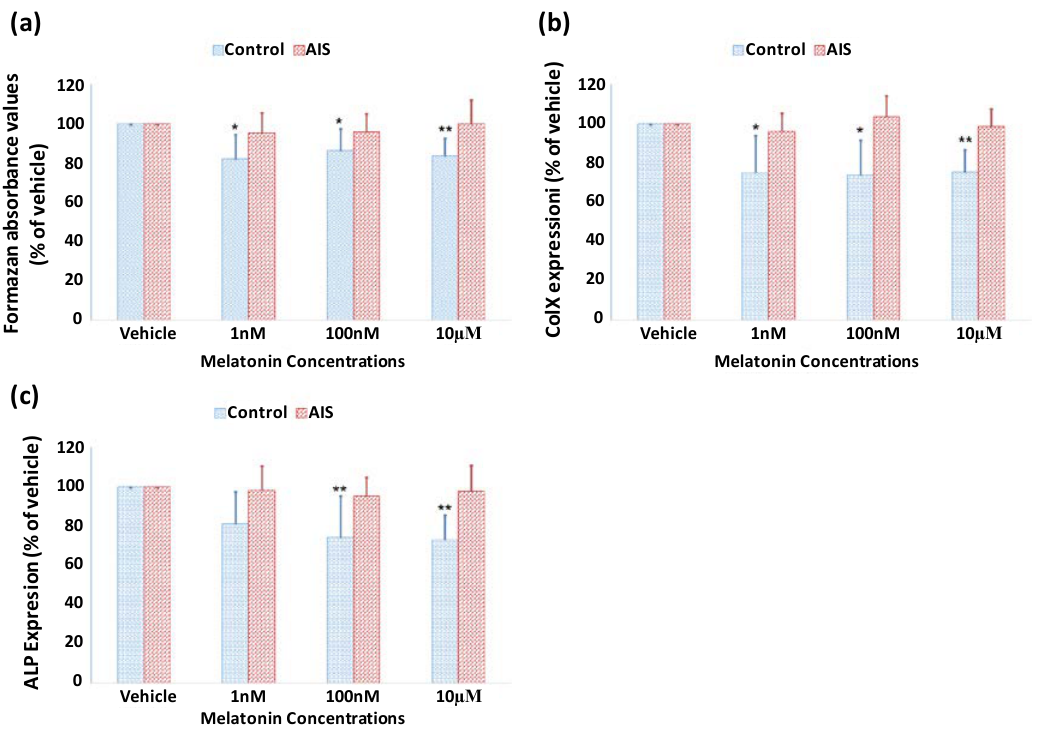
Figure 3. Lack of effect of melatonin on the proliferation and differentiation of GPCs from AIS patients. GPCs from 20 AIS patients and 10 control adolescents were isolated and cultured. Data represent mean ± standard deviation. The GPCs from AIS patients showed no response to the melatonin treatment in proliferation ( a ); and gene expression of COLX ( b ) and ALP ( c ). ( * p < 0.05, ** p <